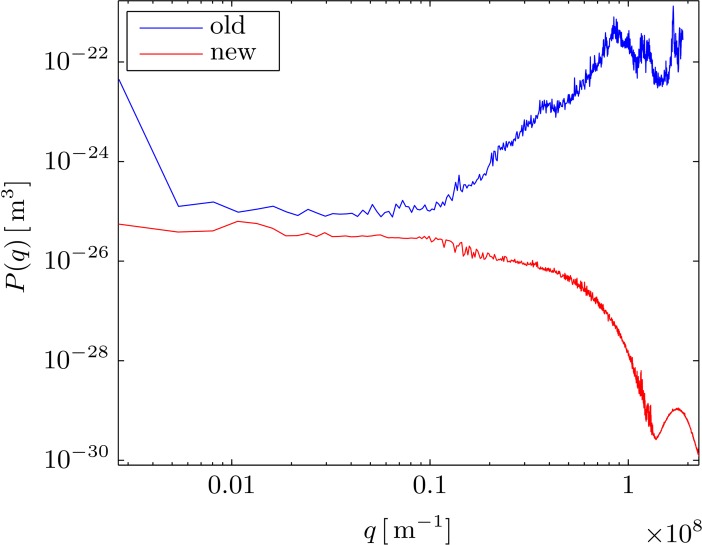
Comparison of spectra obtained from the same dataset (SNR = 106.7) using the new and old algorithm.The spectrum from the old algorithm increase at high q, since the pixilation artifact causes increased noise as the wavelength draws closer to the pixel-size. The spectrum from the new algorithm exhibits a minimum at the location corresponding to wavenumber qpix of a pixel.